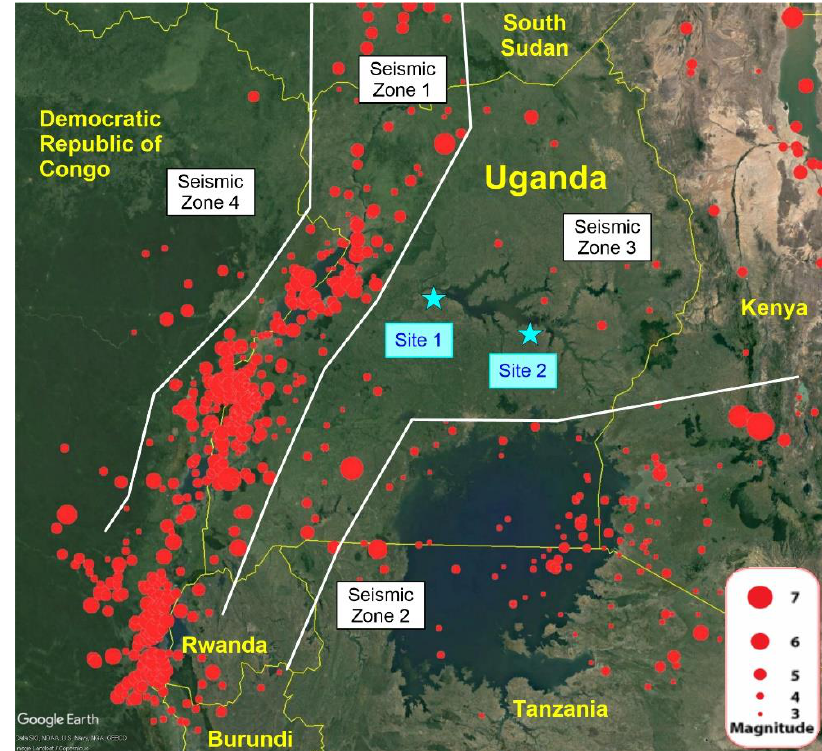
Figure 3. Earthquake epicenters in the Ugandan region for (1912–2020).